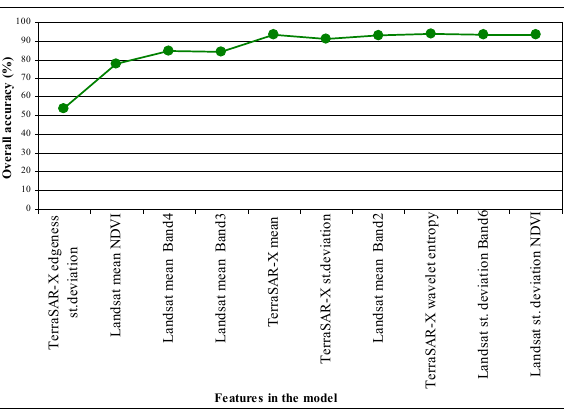
Figure 3. Evolution of the estimated overall accuracy as new descriptives features are introduced into the discriminant model when Landsat 7 ETM+ and TerraSAR-X data are combined. Using only these features, the overall accuracy reaches a value close to 85%. The subsequent feature added to the discriminant model is again a texture feature, corresponding to the mean